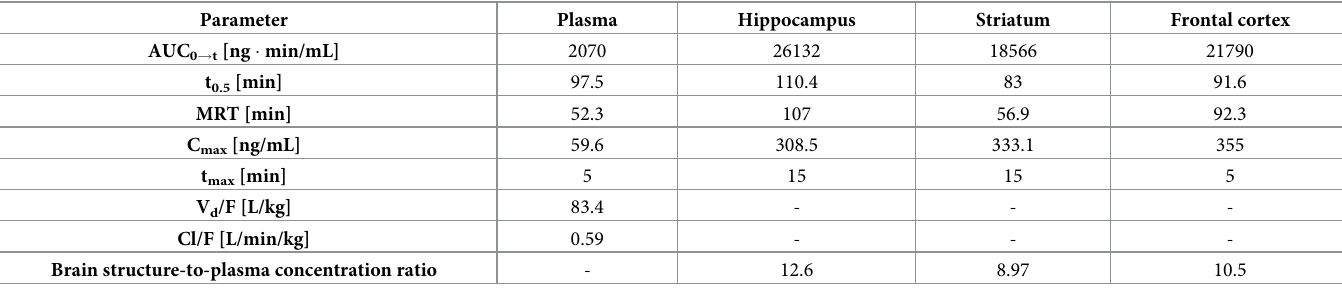
Brain structure-to-plasma concentration ratio AZ-861 administered to mice i . p . at the dose of 1.25 mg/kg. AUC 0 ! t − area under the curve from zero to last sampling time; t 0.5 –terminal half-life; C max −